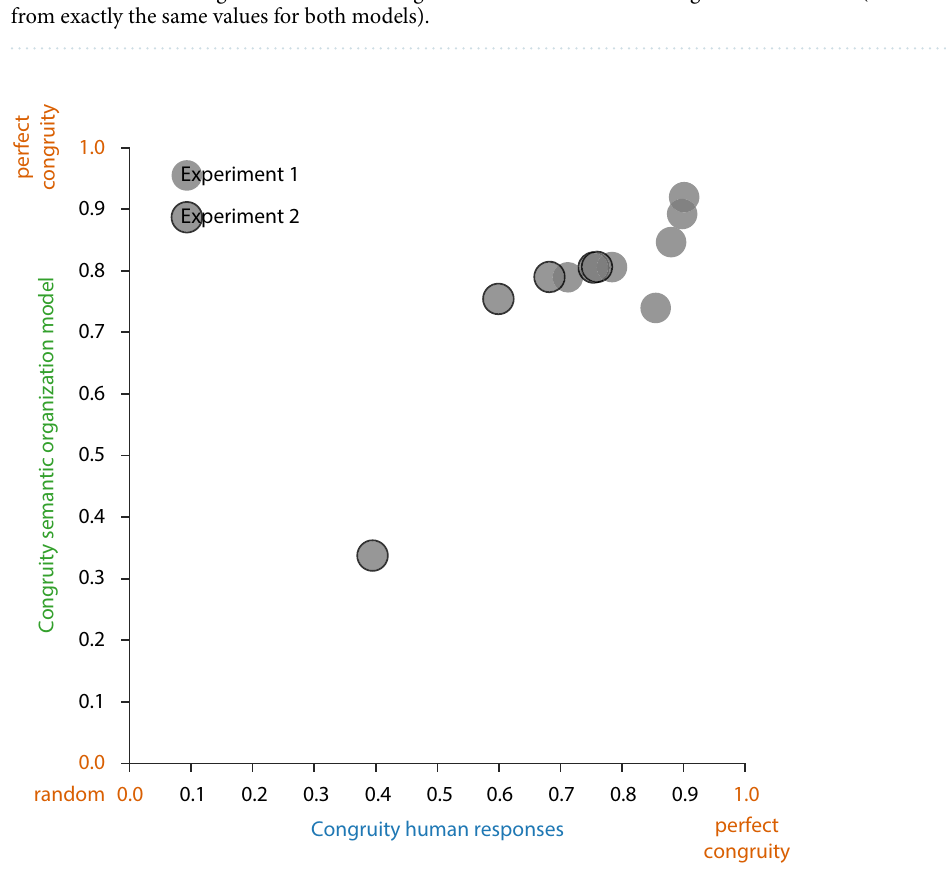
Figure 11. Congruity of the semantic organization model plotted against the congruity of human responses, separately for each stimulus pair in Experiments 1 and 2. As in Figs. 9 and 10, we plot response congruity on a continuum between random (0.0: congruity between responses of random model) and perfect congruity to human responses (1.0: all responses on top of each